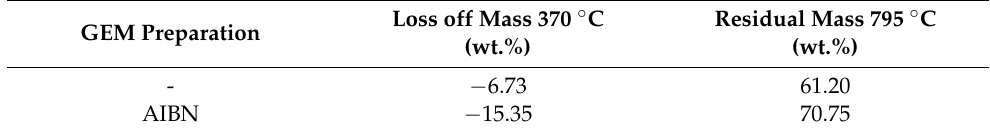
Table 1. Influence of radical initiator and radical inhibitor in the reaction. GEM